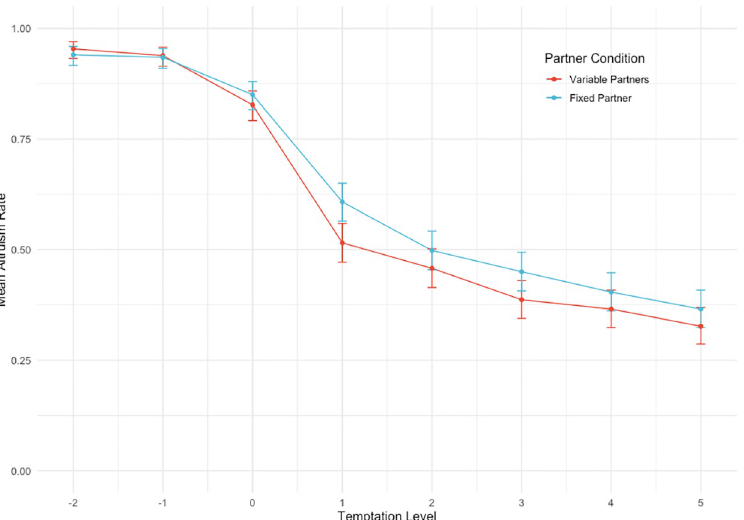
Fig 4. Experiment 1 data. Graphs show mean altruism rates (proportion of trials in which participants chose the coordination option) by Partner Condition for the corresponding temptation level (see: Methods) of participants’ alternative option. Points represent where empirical data was collected, and error bars represent 95% confidence intervals calculated using binomial tests. Regression results (see Table 1) show that altruism rates were significantly higher when participants coordinated with the same partner (Fixed Partner) on every trial than when coordinating with different partners (Variable Partners) on each trial. In addition, altruism rates are significantly decreasing with increases in the level of temptation of the alternative